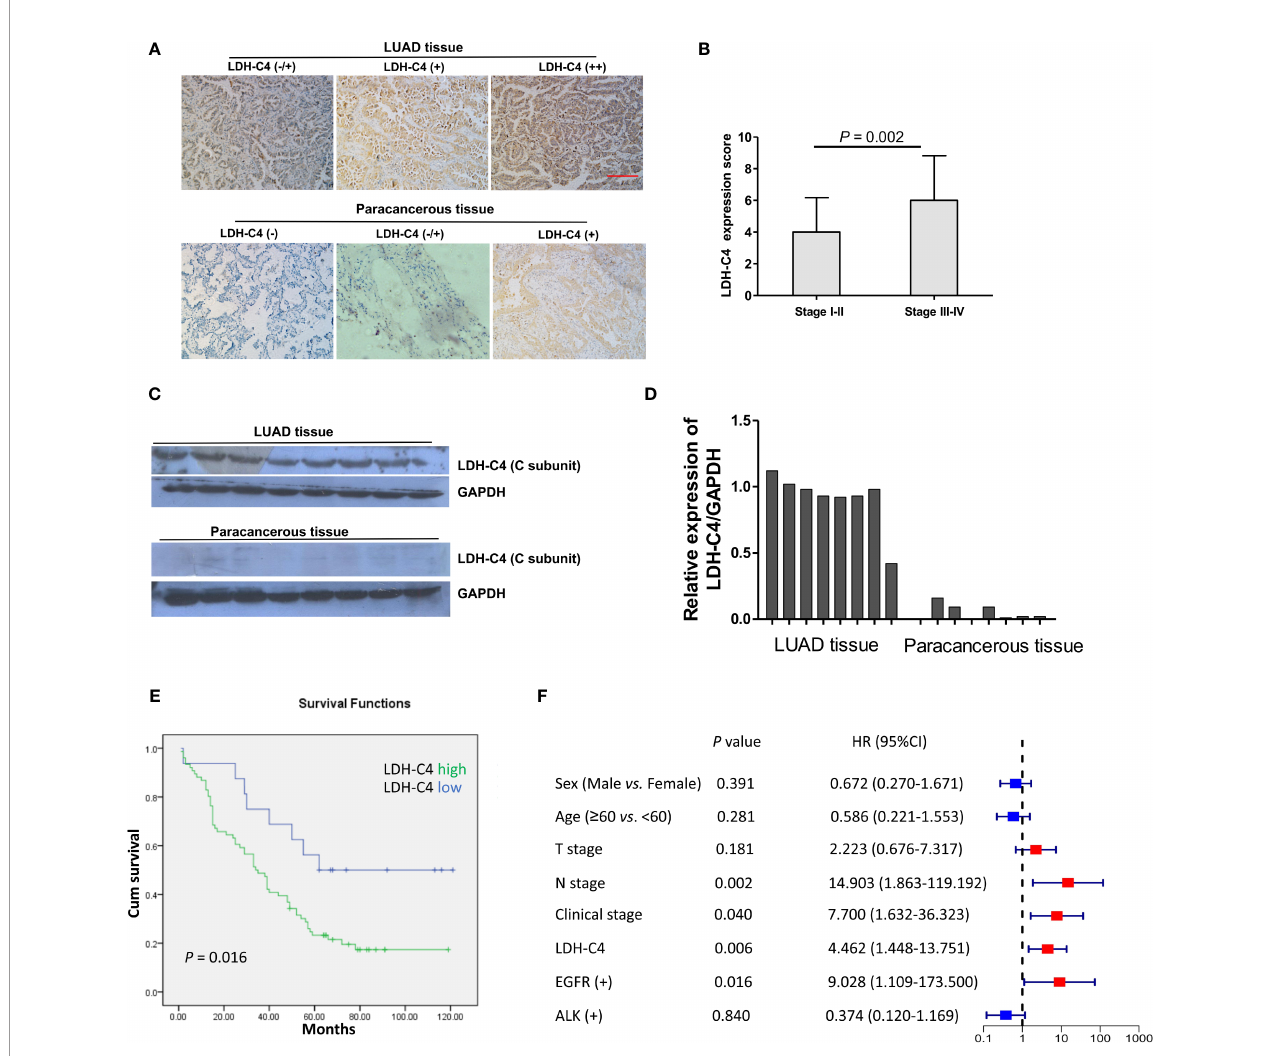
FIGURE 5 | Expression of LDH-C4 protein in LUAD and its prognostic value. (A) The expression of LDH-C4 in LUAD and adjacent tissues was detected by IHC analysis based on tissue microarray. (B) The expression score of LDH-C4 protein in LUAD patients with stage I + II was lower than that in LUAD patients with stage III + IV. (C, D) Immunoblotting was used to detect the expression of LDH-C4 in LUAD patients and matched paracancerous tissues ( n = 8). (E) Patients with high expression of LDH-C4 showed poorer overall survival time. (F) The 5-year relative risk analysis based on clinicopathological parameters of LUAD